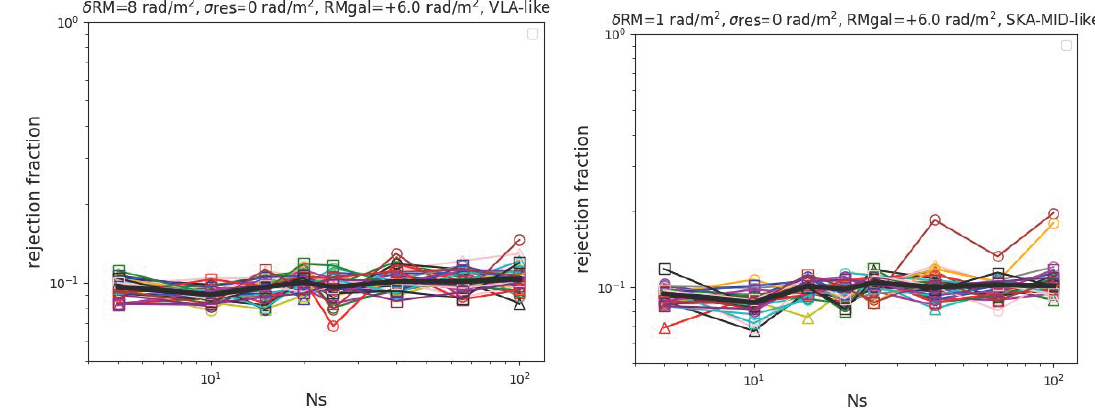
Figure 7. Same as Figure 2 for the AGN seeding